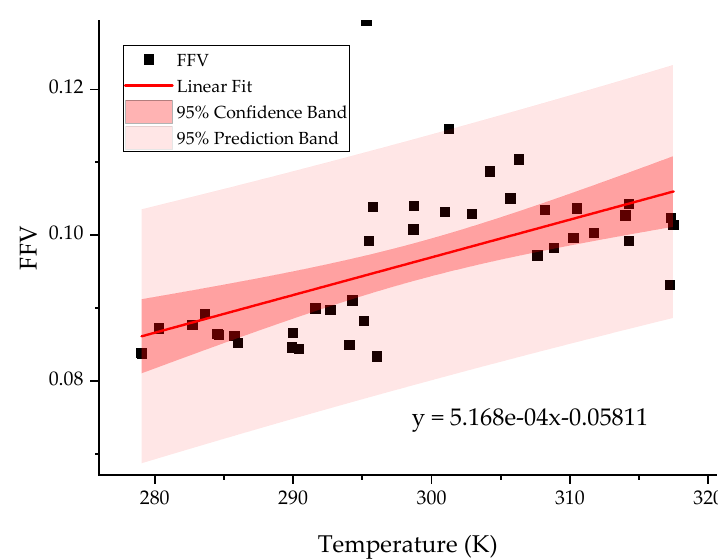
Figure 7. The dependence of FFV on temperature. The value of the slope of linear correlation (red line) is 5.168 ∗ 10 − 4 ± 1.09 ∗ 10 − 4 1 . The red and pink areas denote 95% confidence and prediction intervals respectively.